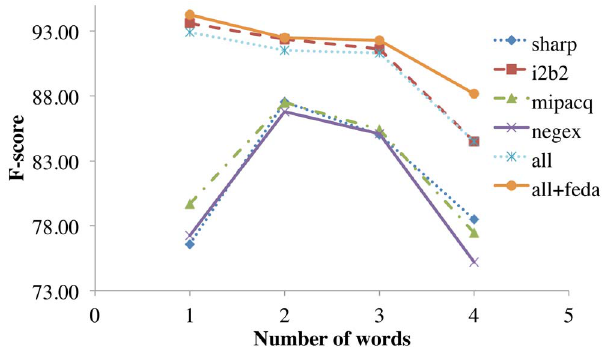
Figure 4. The effect of named entity length (in number of words) on performance for each of 6 training configurations. SHARP, MiPACQ, and i2b2 test sets are used for evaluation.